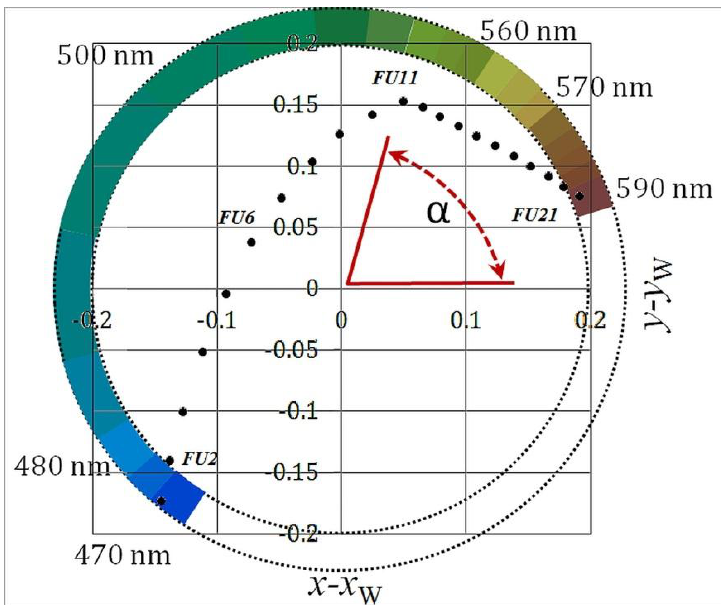
Figure 2. A chromaticity diagram showing the hue colour angle (α) match relative to the white point ( x w , y w ) of the FU scale colours. The dominant wavelength of the specific segment is indicated in